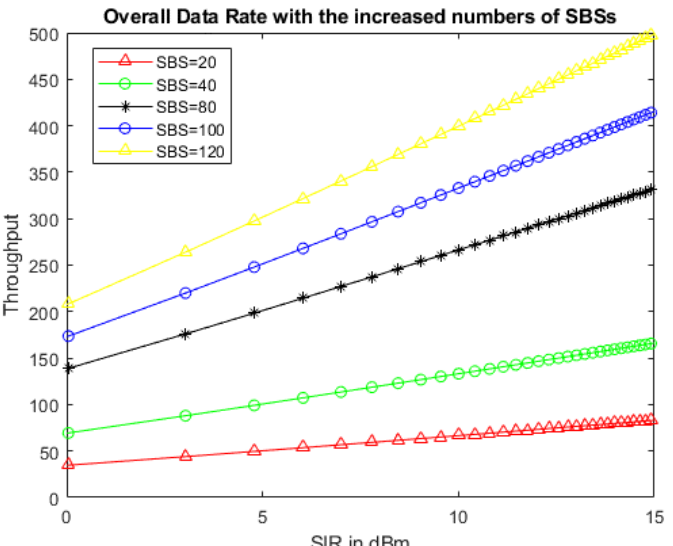
Figure 9. System throughput achieved with the IMHC scheme by increasing the number of SBSs in HetNet.